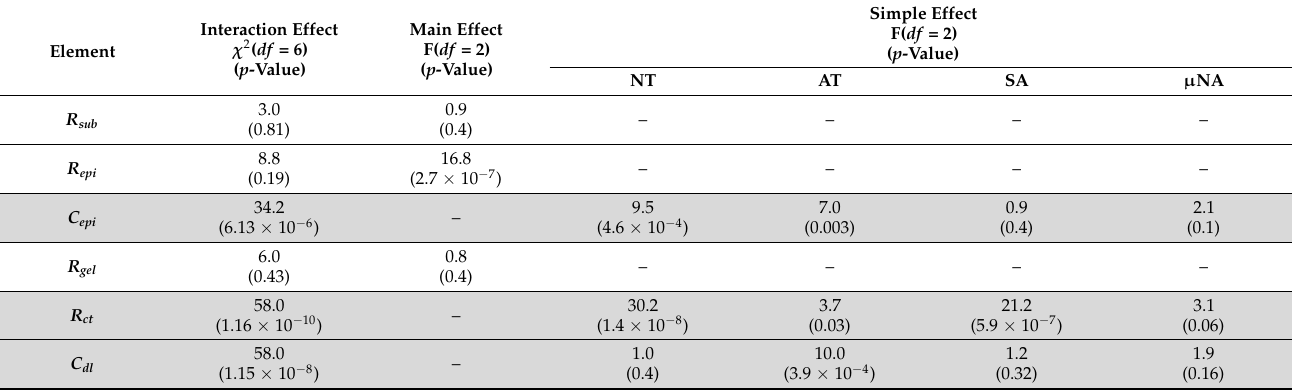
Figure 4. Time evolution of the fitted, area-normalized circuit model parameters over 24 h. ( a – c ) Skin-level results for each treatment type, showing time evolution of the values of the ( a ) subcutaneous resistance, ( b ) epidermal resistance, and ( c ) epidermal capacitance. ( d – f ) Electrode-level results for each treatment type, showing time evolution of the values of the ( d ) gelled electrolyte resistance, ( e ) charge-transfer resistance, and ( f ) double-layer capacitance. Bars represent means, errorbars are standard deviations ( N = 14); t 0 — initial timepoint, t mid — study midpoint, 8 h. after skin treatment application, t f — final timepoint, 24 h. after skin treatment application. Significance levels: (*) denotes p < 0.05, (***) denotes p < 0.01 (values are reported Table 2). Table 2. Results of likelihood ratio testing (LRT) for the equivalent circuit model parameters. The significance level was set to p = 0.05.